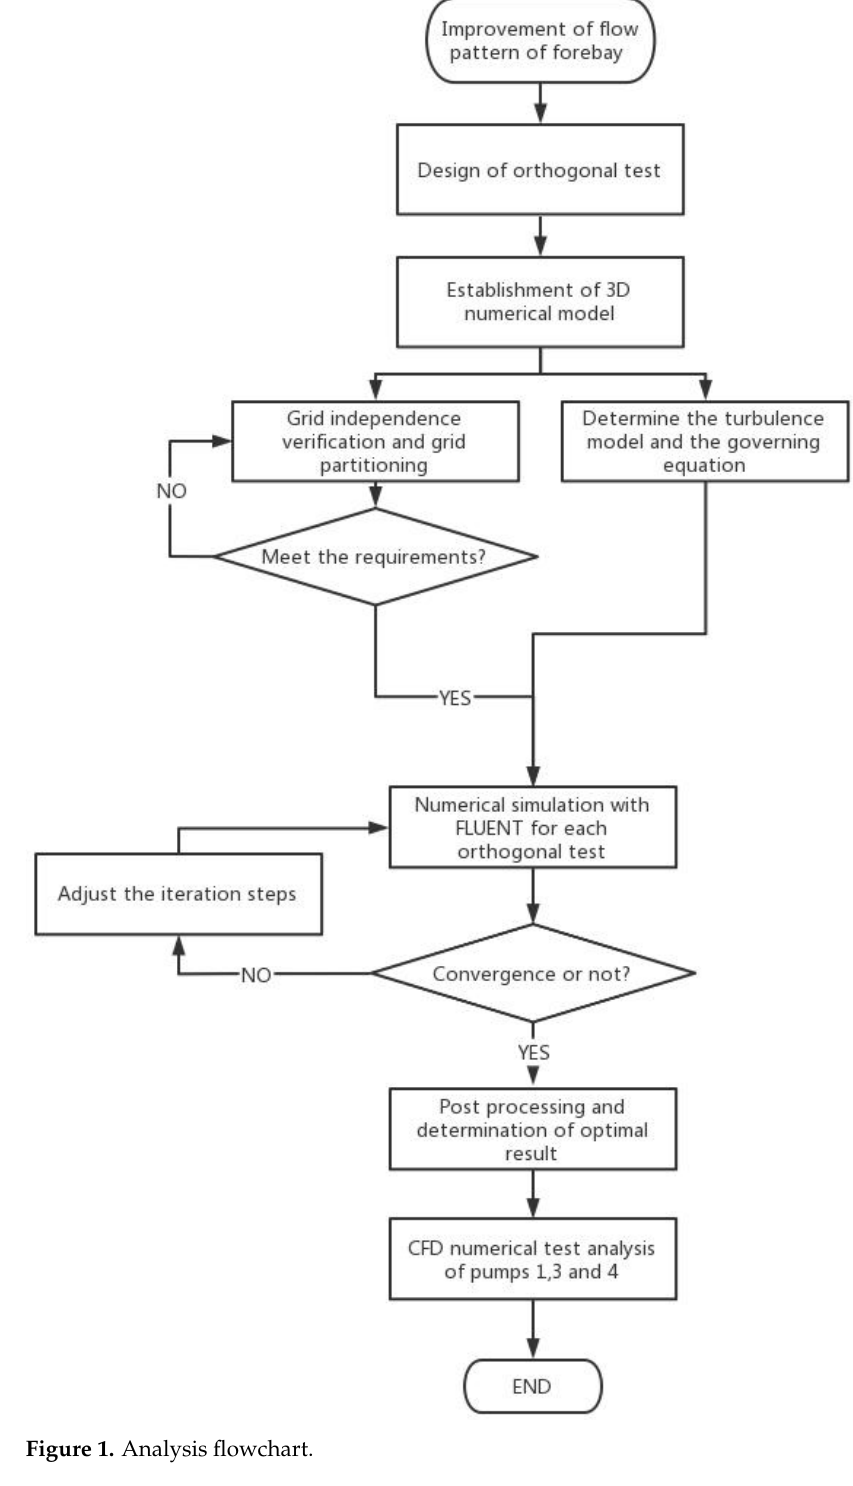
Figure 1. Analysis Figure 1. Analysis flowchart.